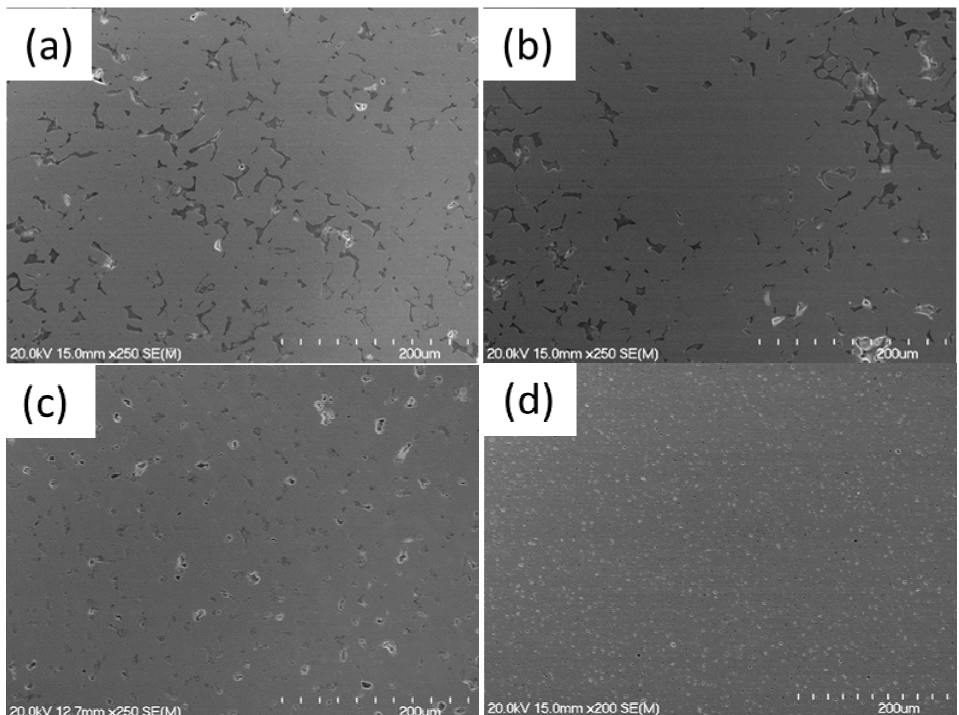
Figure 6. SEM images of the as-sintered NiMnFeCu under low magnification. ( a ) At 1000 °C for 1 h